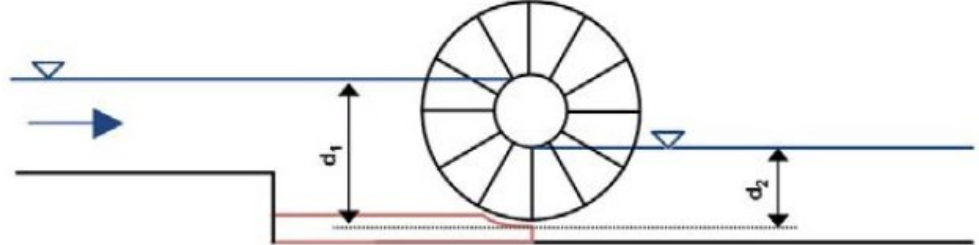
Figure 2. Diagram of the HPM with straight blades tested in the HYLOW project. Taken from [38].